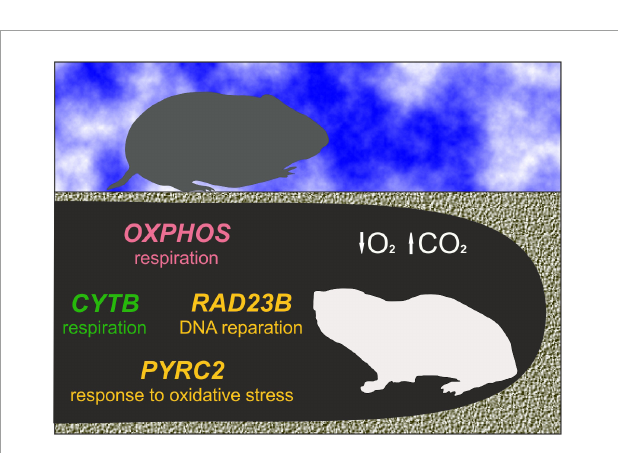
FIGURE4 Graphic representation of possible molecular adaptations in response to subterranean life. Genes are colored as follows: Red—under positive selection in at least one subterranean lineage; yellow—with parallel substitution in at least one pair of subterranean taxa;